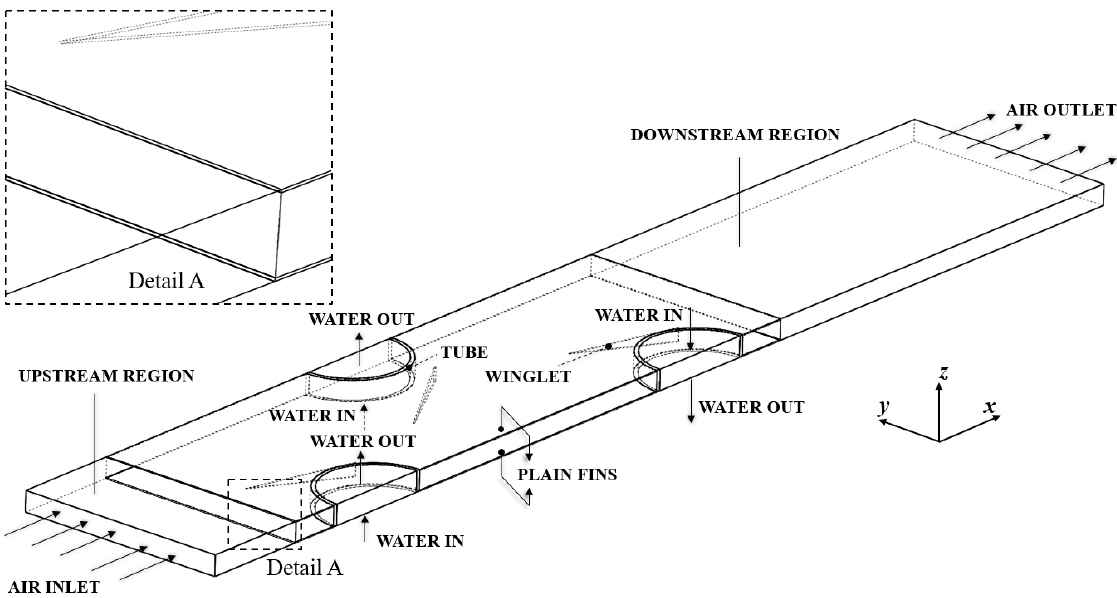
Figure 4. Computational domain of air-to-water fin-and-tube heat exchanger with delta-winglet type vortex generators.